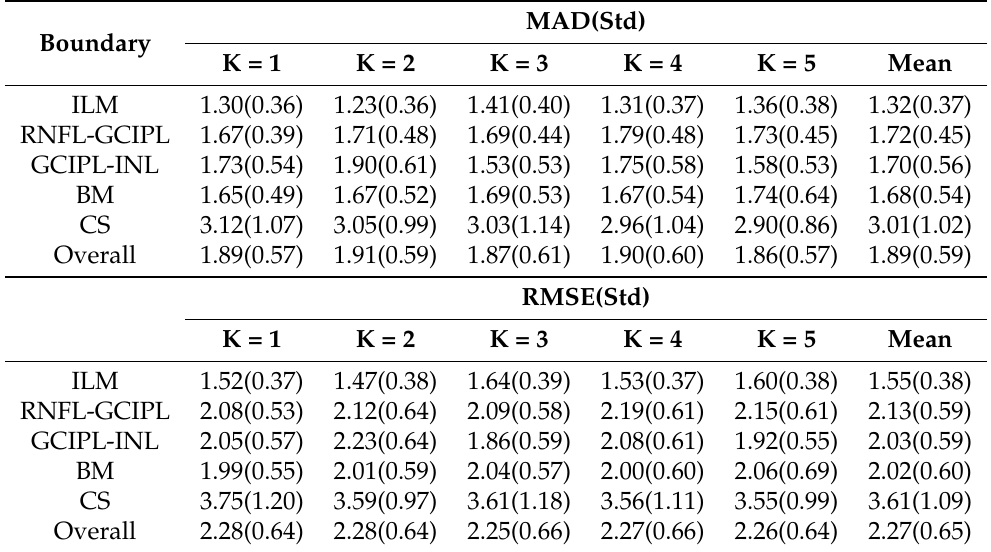
Table 5. Test results of MAD and RMSE with five-fold cross-validation.